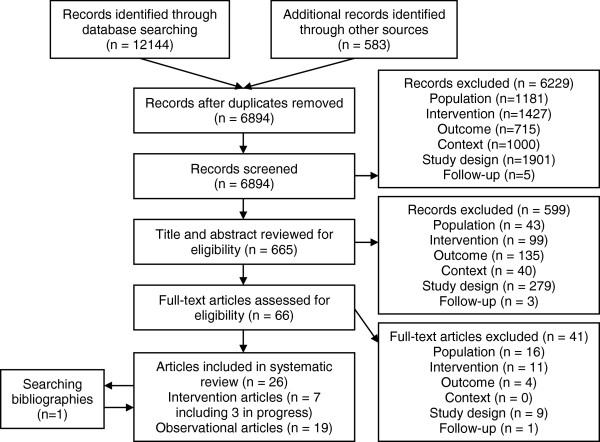
PRISMA Flow diagram [32] of the identification of literature for inclusion in this systematic review.